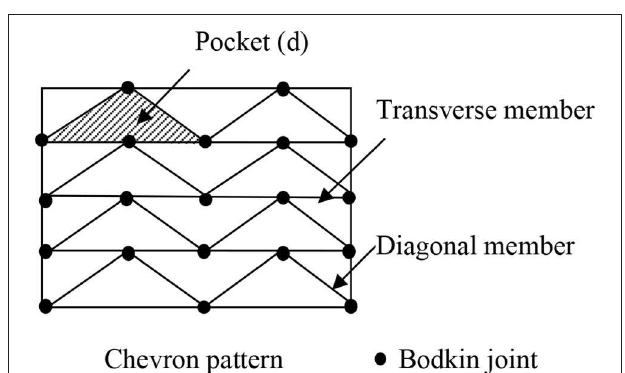
FIGURE 2 | Pattern of formation of geocell mattress.